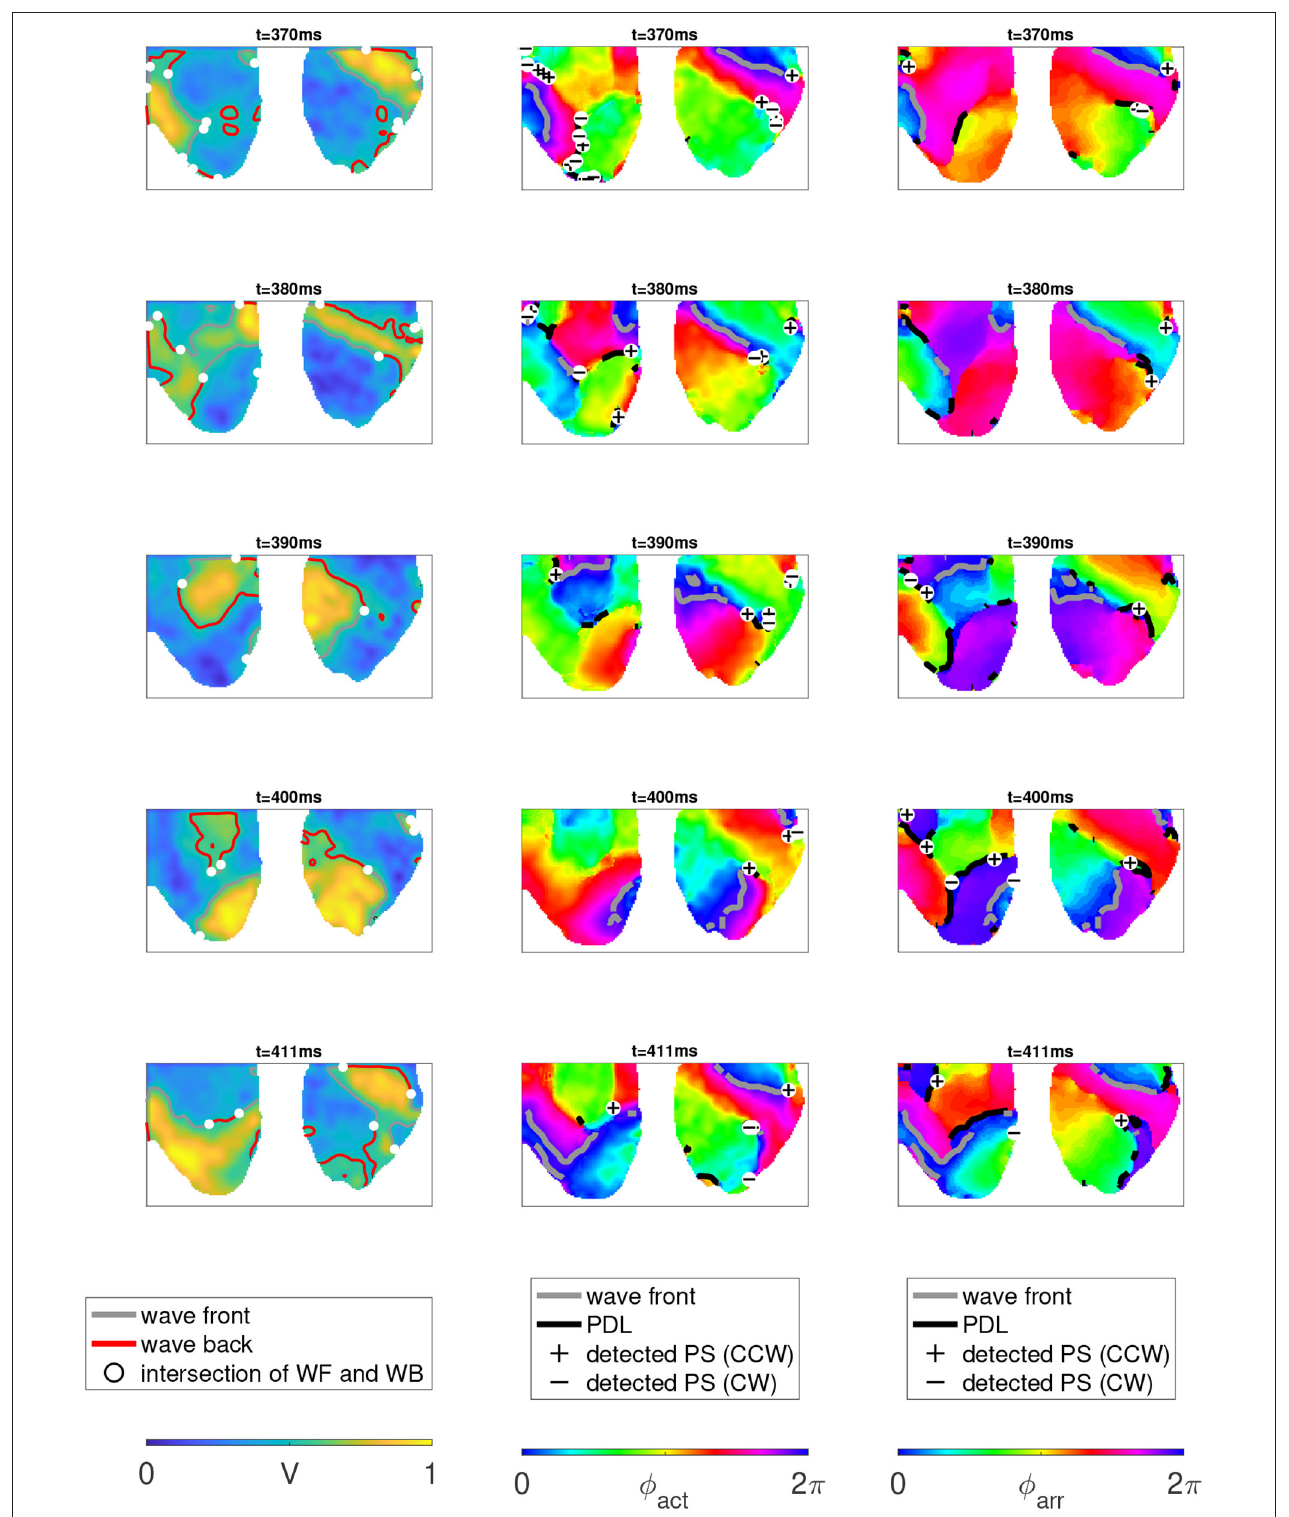
FIGURE 13 | Analysis of two-sided optical mapping data in rabbit hearts during ventricular tachycardia. Left : normalized optical intensity (transmembrane voltage) V , together with WF ( V * 0.5, ˙ V > 0) and wave back ( V * 0.5, ˙ V < 0). Middle : same data series, φ act computed with R the Hilbert transform of V , with PSs and PDLs = = computed from φ act . Right : colormap indicates φ arr , computed with τ 99ms, equal to the inverse dominant frequency. PSs and PDLs computed from φ arr are also = shown. PS detection was done using the 2 2 4 4 method of Kuklik et al. × + ×